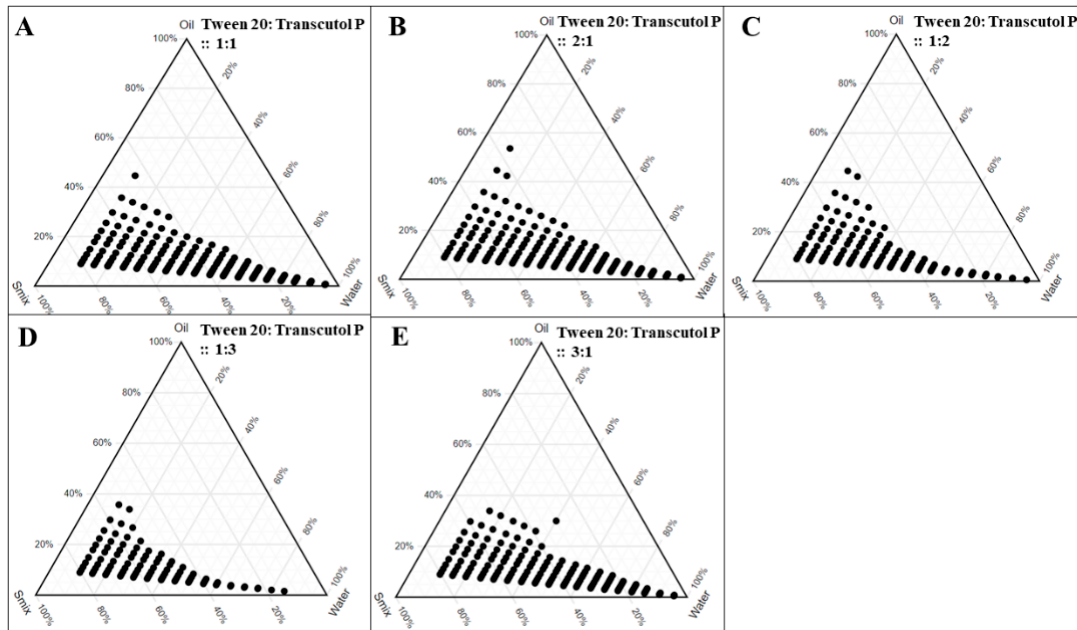
Figure 3. Pseudoternary phase diagrams of Capryol 90 (oil phase) to obtain the nanoemulsion area (as denoted by solid circles) with different ratios of Smix (Tween 20 and Transcutol P): A . 1:1, B . 2:1, denoted by solid circles) with di ff erent ratios of Smix (Tween 20 and Transcutol P): A . 1:1, B . 2:1, C . 1:2, C . 1:2, D . 1:3, and E . 3:1. D . 1:3, and E .